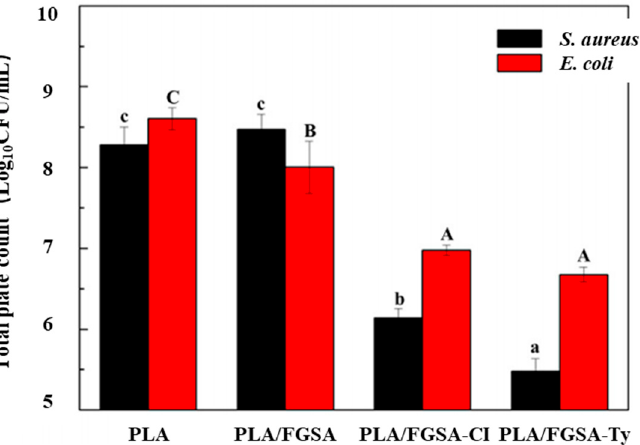
Figure 4. The bacteria populations in different groups were studied and shown at the end of storage.